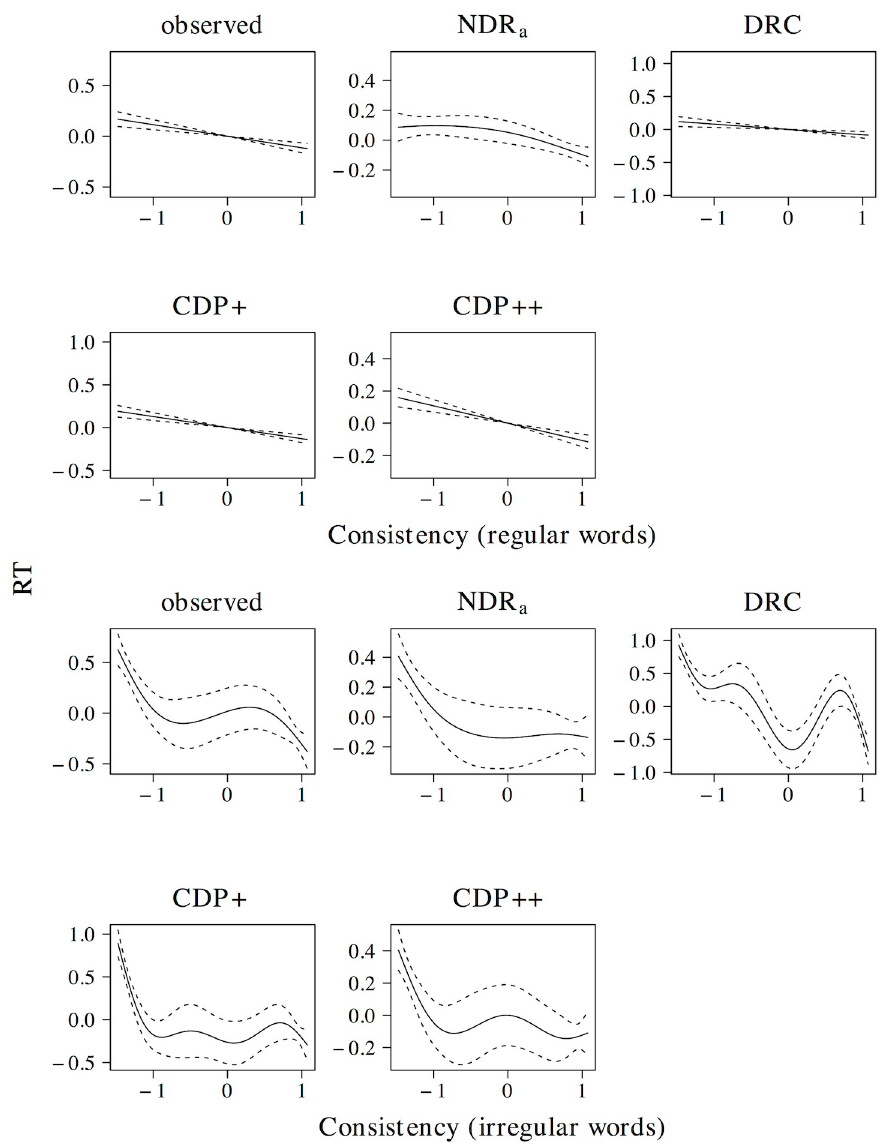
Fig 13. Interplay of consistency and regularity. The interplay of consistency and regularity in word naming. Top two rows shows results for regular words, bottom two rows for irregular words.